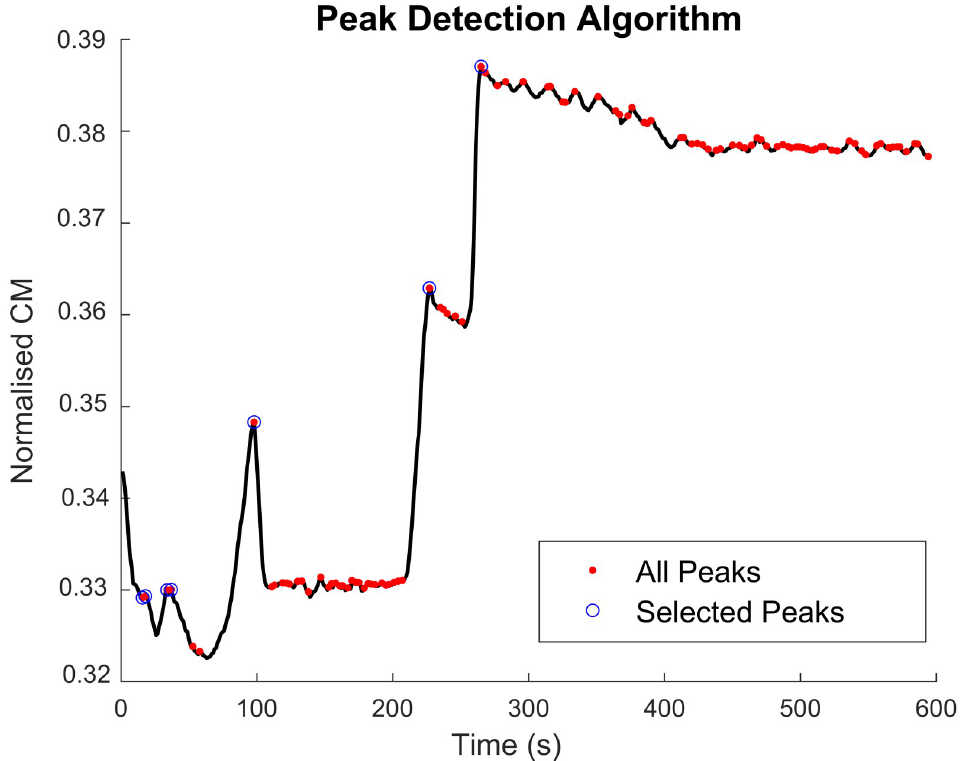
Fig 3. Results of the real-time peak detection algorithm. All peaks of the CM signal are shown as red dots. The peaks detected by the algorithm as those an expert would pick in determining drops are shown in blue circles.